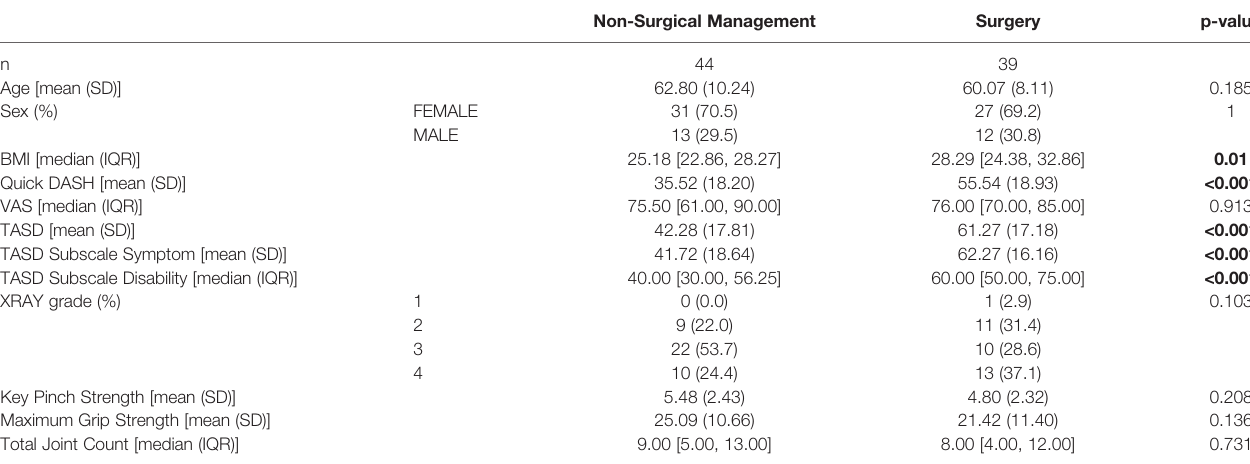
TABLE 1 | Baseline Patient